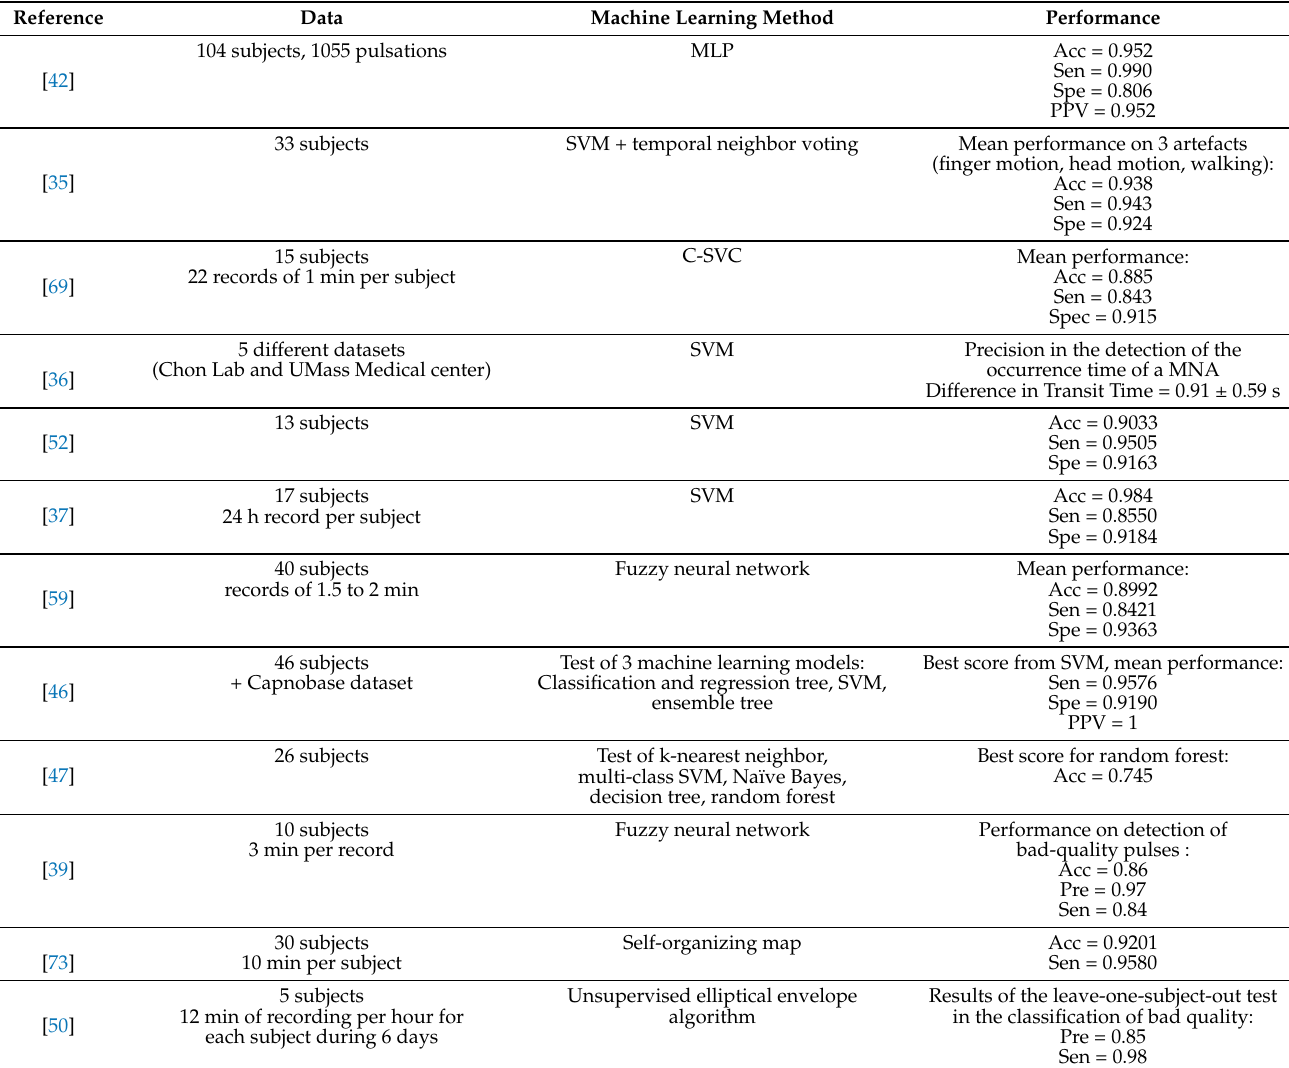
Table 6. Summary of machine learning methods dedicated to quality